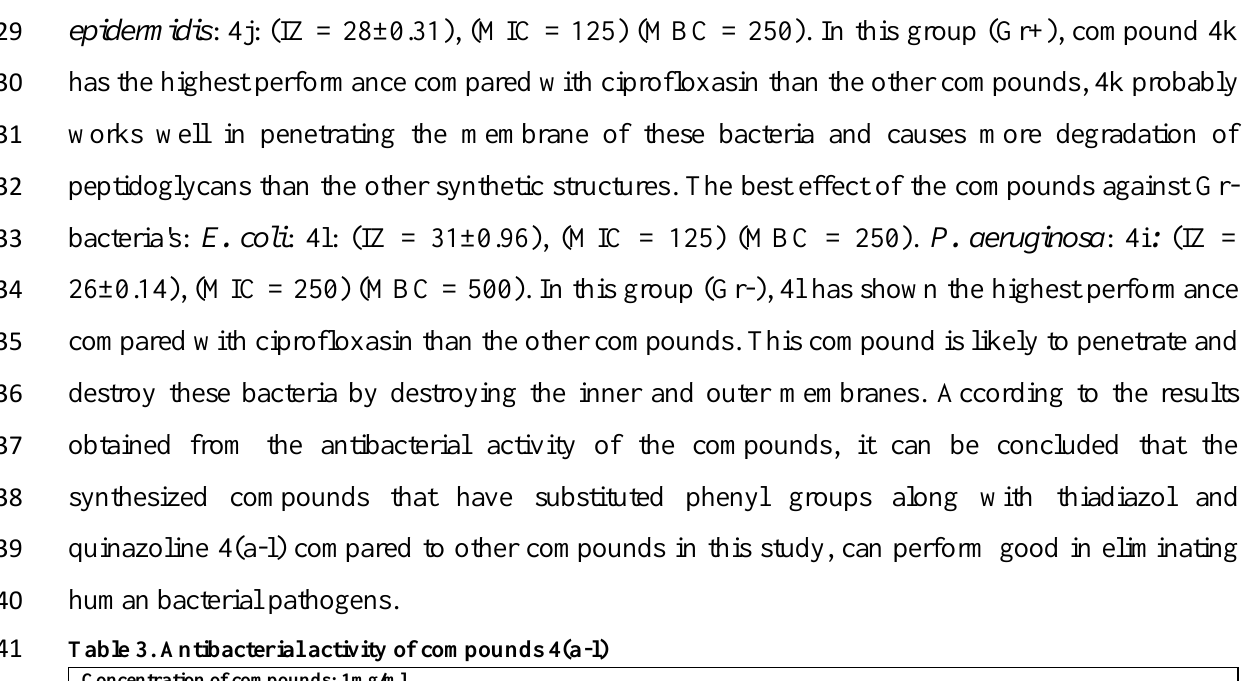
Table 3. Antibacterial activity of compounds 4(a-l) 341 Concentration of compounds: 1mg/ml Inhibition Zone (IZ):